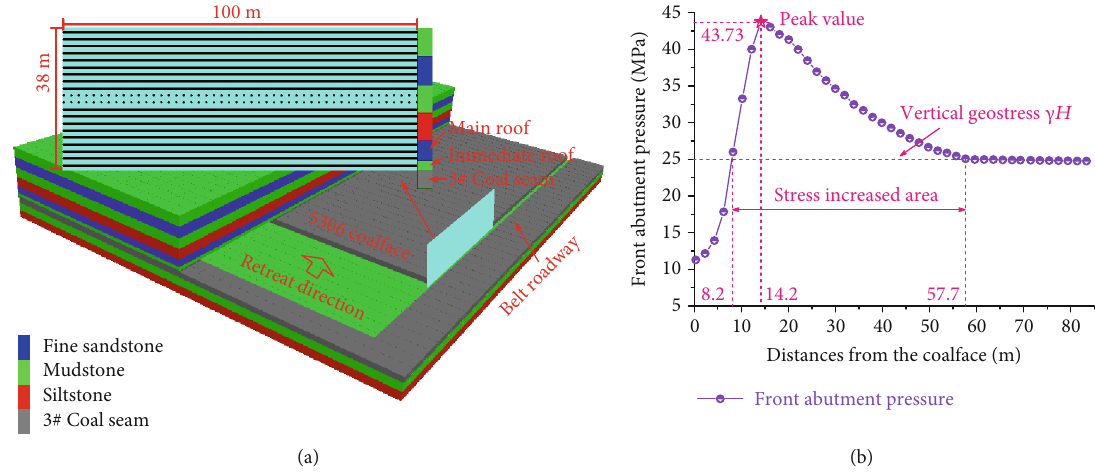
Figure 8: Layout of the measuring lines and distribution of the front abutment pressure: (a) measuring lines layout; (b) front abutment pressure distribution.